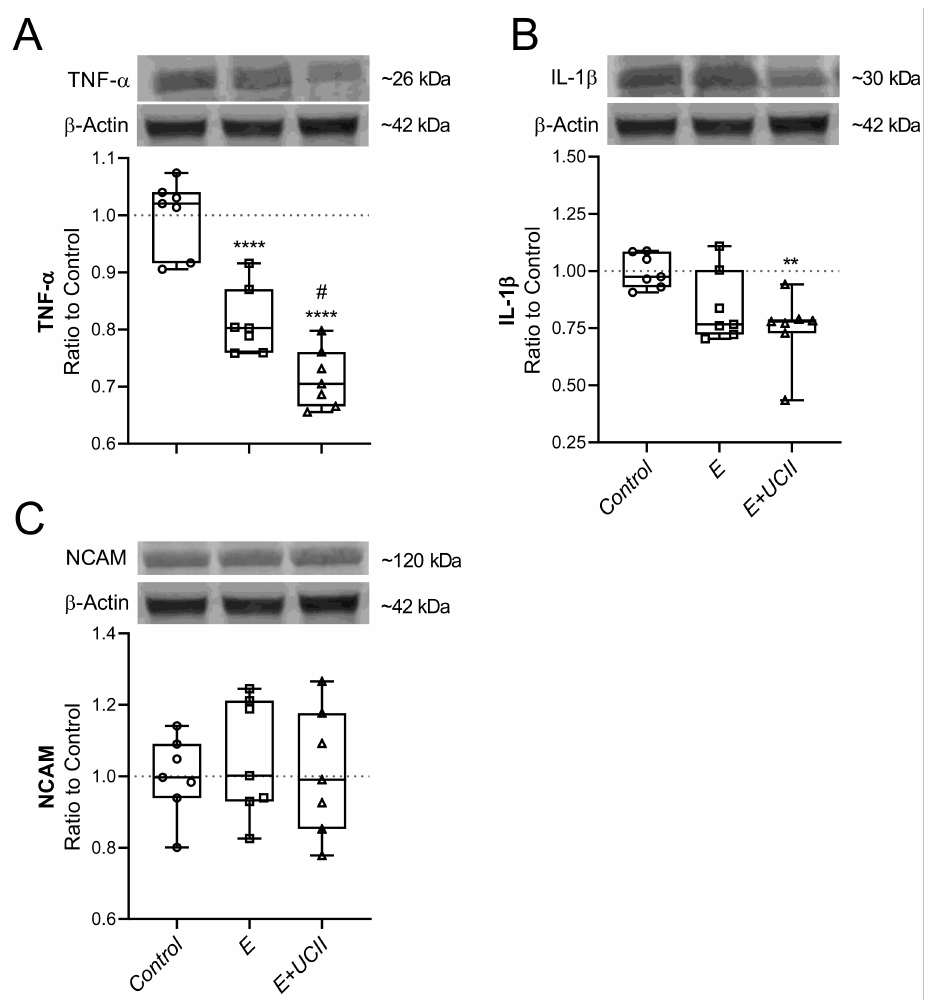
Figure 6. The effect of UCII on the muscle TNF- α ( A ), IL-1 β ( B ), and NCAM ( C ) levels in exercised rats. The densitometric analysis of the relative intensity according to the control group of the western blot bands (Figure S3) was performed with β -actin normalization to ensure equal protein loading. Blots were repeated at least three times ( n = 3), and a representative blot is shown. Box and Whisker plots show median, min, and max values. Data are expressed as a ratio of the control set at 1.0. ANOVA and Tukey’s post-hoc test were used to compare the results among different treatment groups. Statistical significance between groups is shown by: ** p < 0.01; **** p < 0.0001 compared to the control group and, # p < 0.05 compared to the exercise group. E: Exercise; UCII, Undenatured type II collagen; TNF- α , Tumor necrosis factor- α ; IL-1 β , Interleukin-1 β ; NCAM, Neural cell adhesion molecules, Control (Circle): no exercise and no UCII, E (Square): exercised rats, E + UCII (triangle), exercised rats receiving 4 mg/kg BW/day